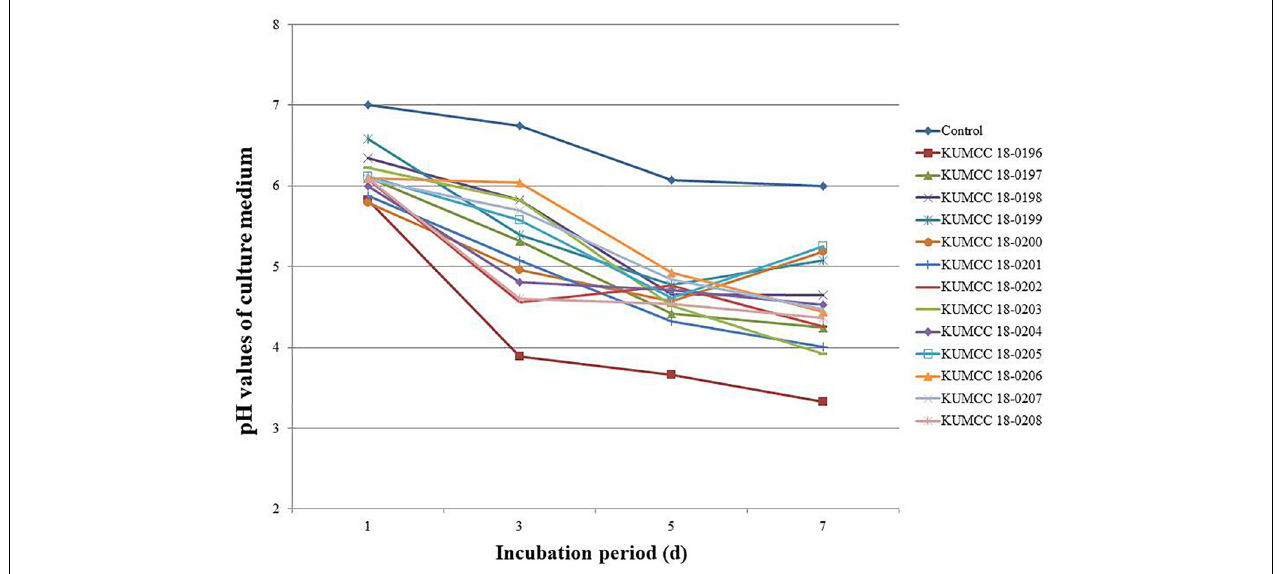
FIGURE 4 | pH values of PVK broth containing TCP inoculated with each 13 fungal isolate and control after the 1 st , 3 rd , 5 th , and 7 th day of incubation (each value represents the mean of the three replicates).